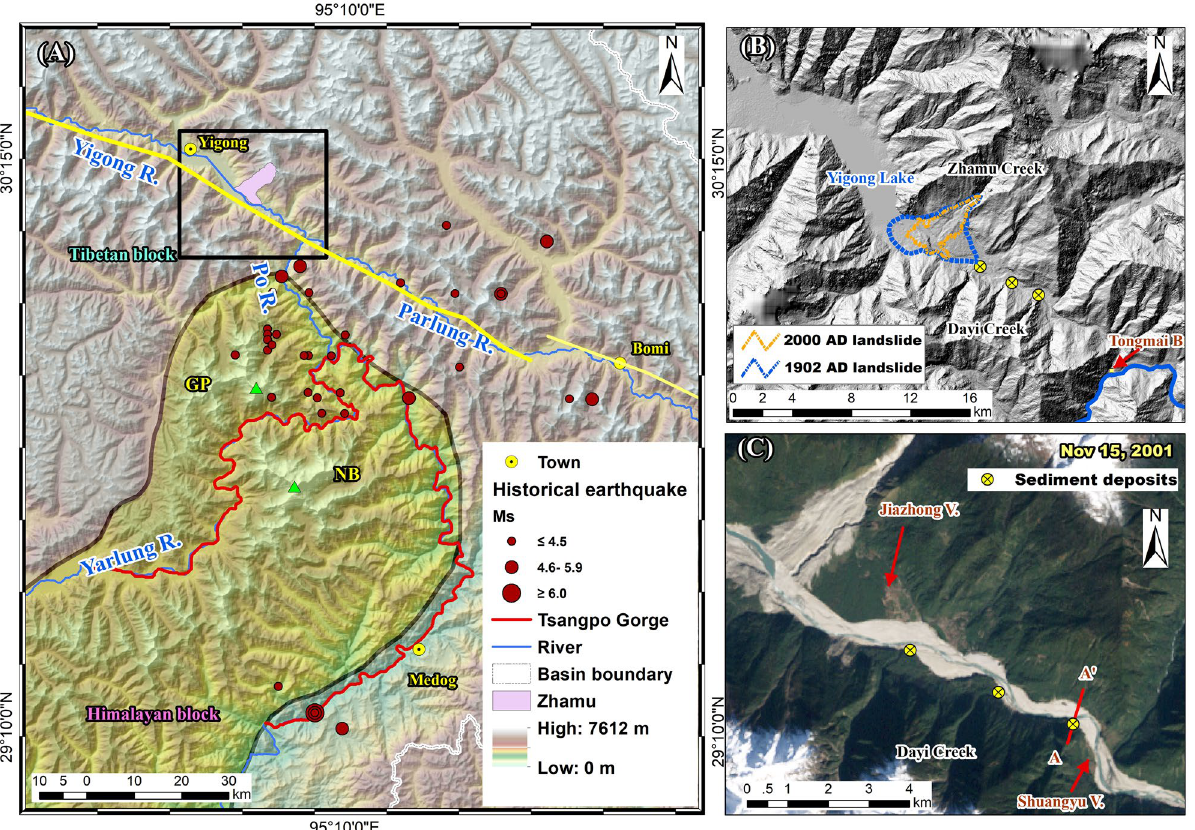
Figure 1. ( A ) Location of the Yigong River and the Yarlung Tsangpo Gorge. The eastward flowing Yigong River turns southward and flows into the gorge after confluence with the westward flowing Parlung River at Tongmai. The topographic map was extracted from NASA’s 90 m Shuttle Radar Topography Mission elevation data. The grey line is the Yarlung Tsangpo suture zone. The yellow lines are the Jiali fault. The black box is the extension of subfigure ( B ). NB denotes the Namche Barwa massif (7782 m), and GP denotes the Gyala Peri massif (7294 m). ( B ) Topographic relief of Yigong’s downstream area mapped with the Advanced Land Observing Satellite-1 (ALOS) 12.5 m DEM. The blue and orange outlines denote the ranges of the 1902 AD and 2000 AD landslide dams, respectively. The yellow circles with black crosses denote the location of the sediment records.